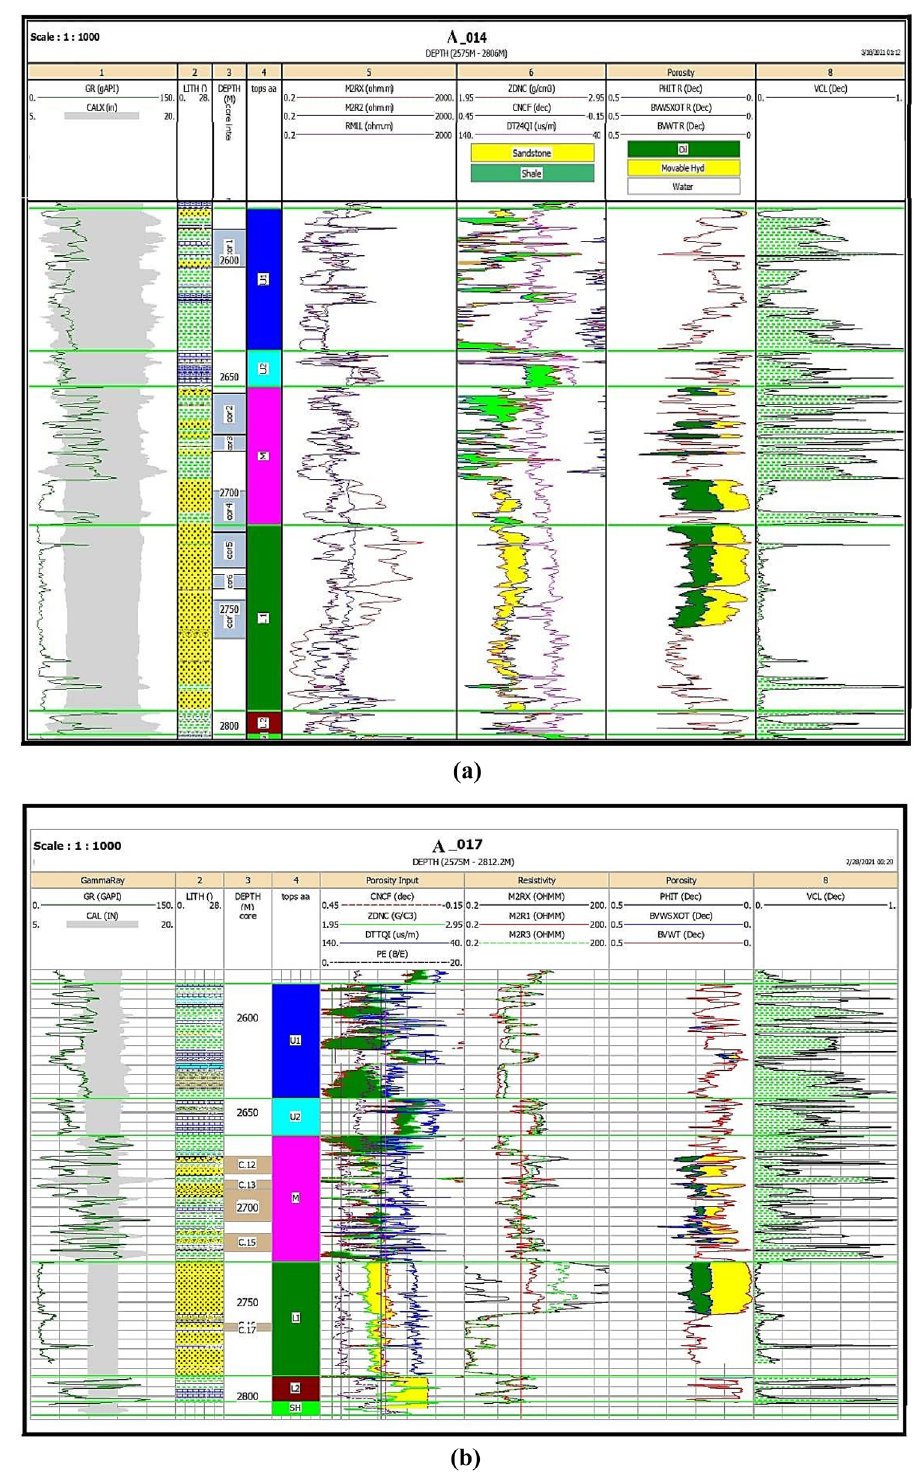
Fig. 7 Litho-saturation vertical plot indicating the different petrophysical values for the Albian sequence reservoir zones in A-014 well ( a ) and A-017 well ( b